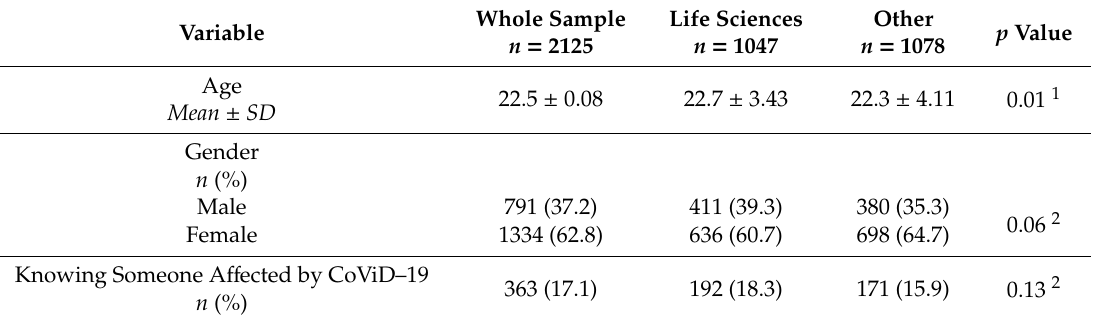
Table 1. Characteristics of the